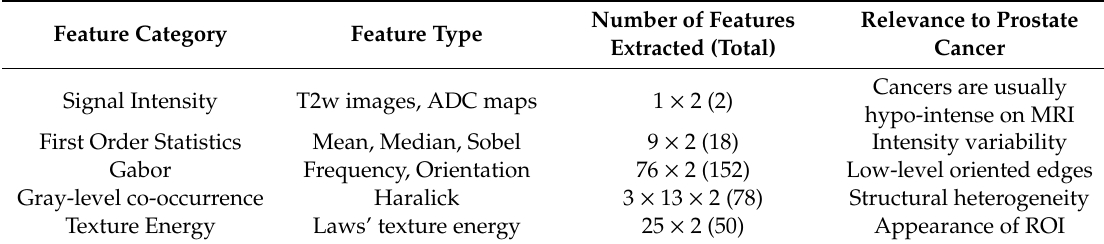
Table 4. Description of Radiomic features